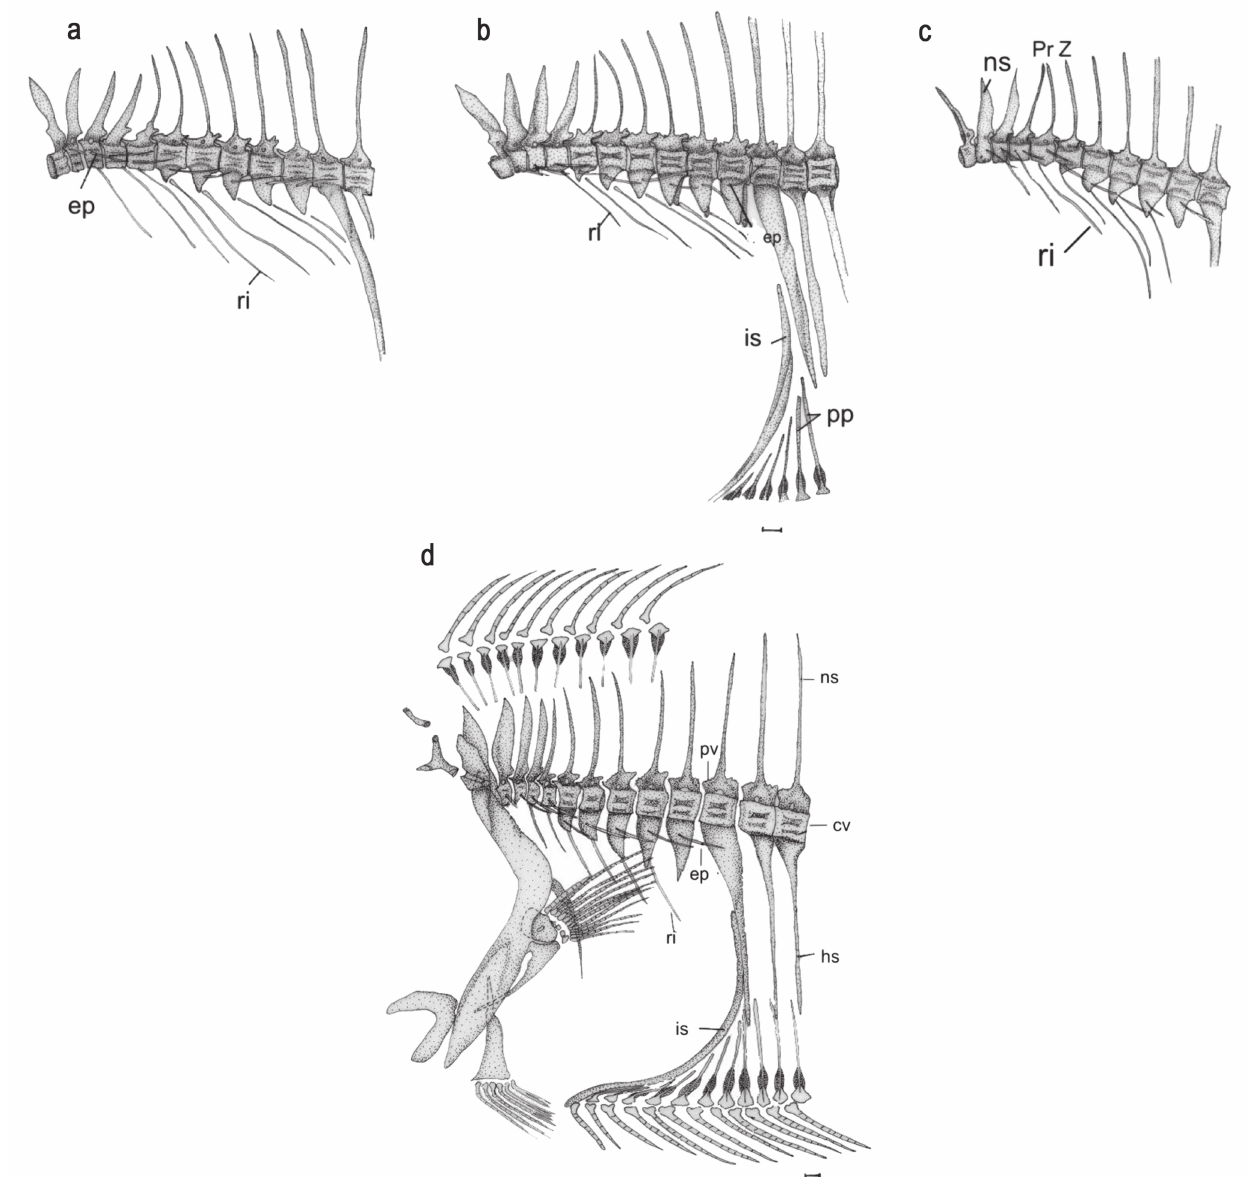
Fig. 3. Skeleton of the precaudal vertebrae region of Paralichthys isosceles ( a); P. orbignyanus ( b and d ); and P. patagonicus ( c ). See abbreviations in text. Scale bar indicates 1